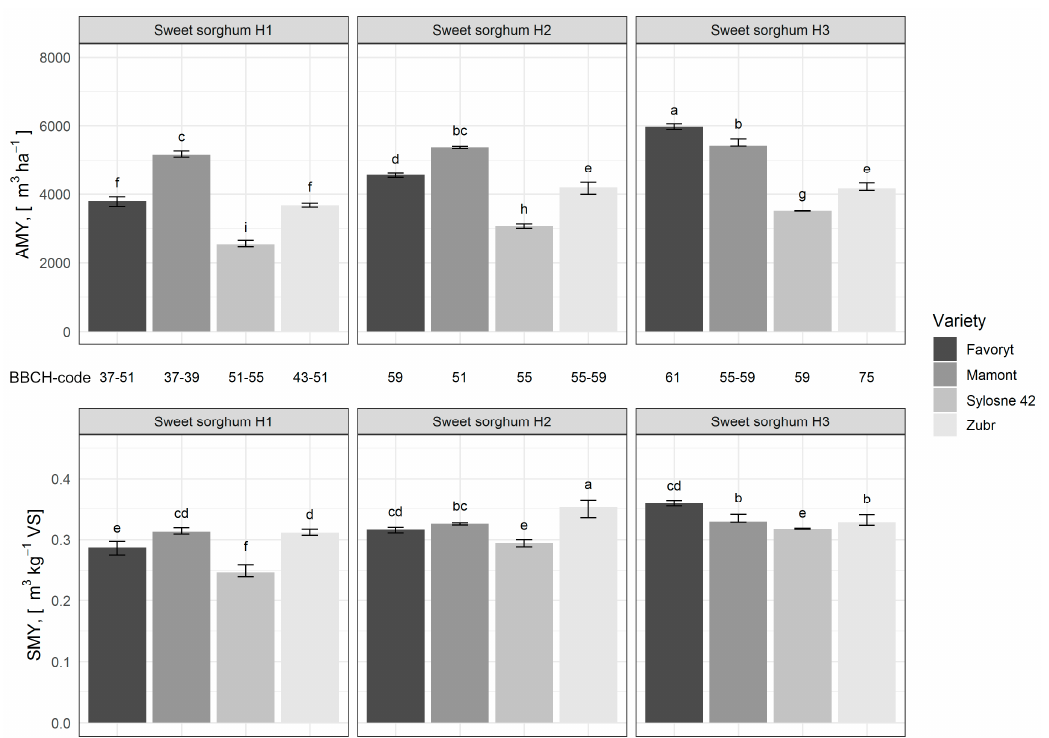
Figure 3. Specific methane yield (SMY) and areal methane yield (AMY) of the sweet sorghum varieties harvested at H1, H2 and H3 harvesting times, which correspond to a certain BBCH-code related to a specific stage of crop phenological development. Histograms are charted based on the mean values; error bars indicate the variability between the three replications. Lower case letters indicate significant di ff erences between all the maize samples according to the results of the Tukey